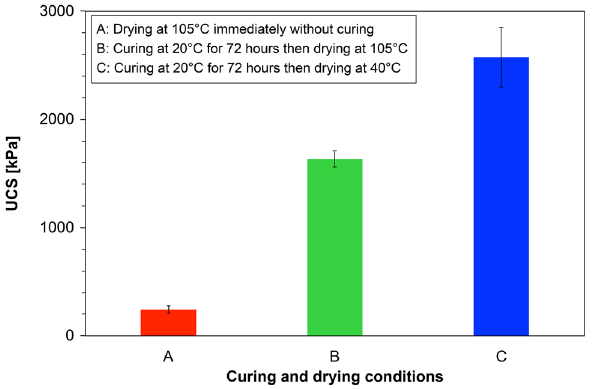
Figure 4. UCS results of the specimens under different curing and drying conditions.